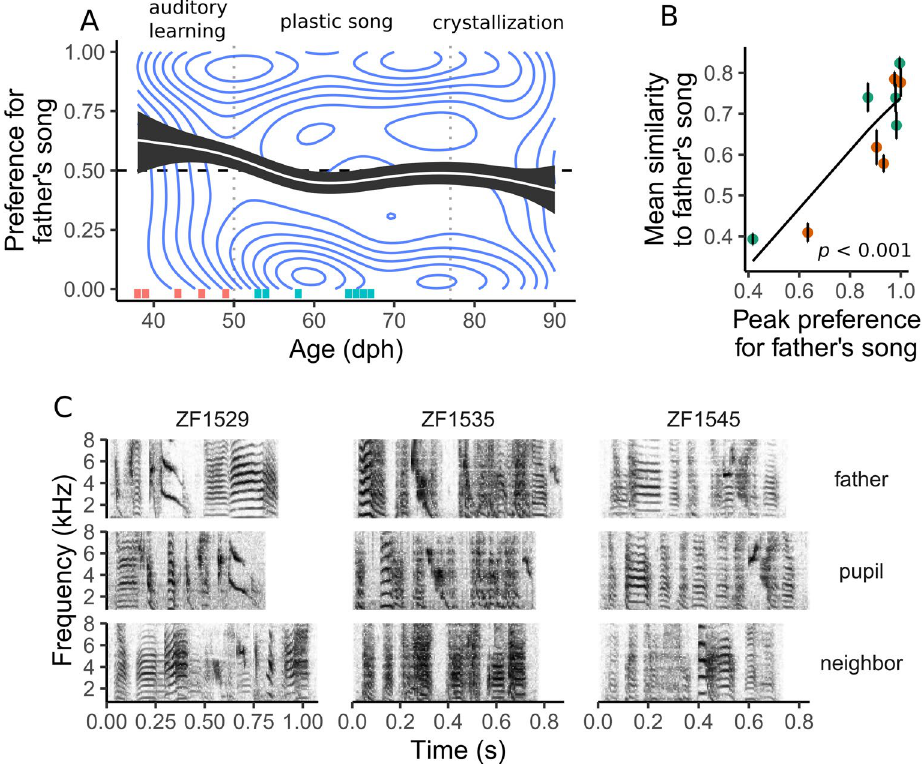
Figure 3. Relationship between the preference for father’s song and imitation of that song. ( A ) The white line shows the average trajectory of the preference for father’s song. The black area indicates the 95% confidence interval. The horizontal dashed line indicates no preference for either song. Vertical dashed lines indicate boundaries between developmental phases (see Fig. 1A). Concentric blue lines represent the 2D density kernel estimation of the daily preference scores. Ticks near the bottom of the plot indicate the age at which individual birds reached their peak preference for father’s song prior to the crystallization phase (for individual trajectories, see Fig. S2). Given that crystallization may begin as early as 70 dph 26 , we chose the maximum